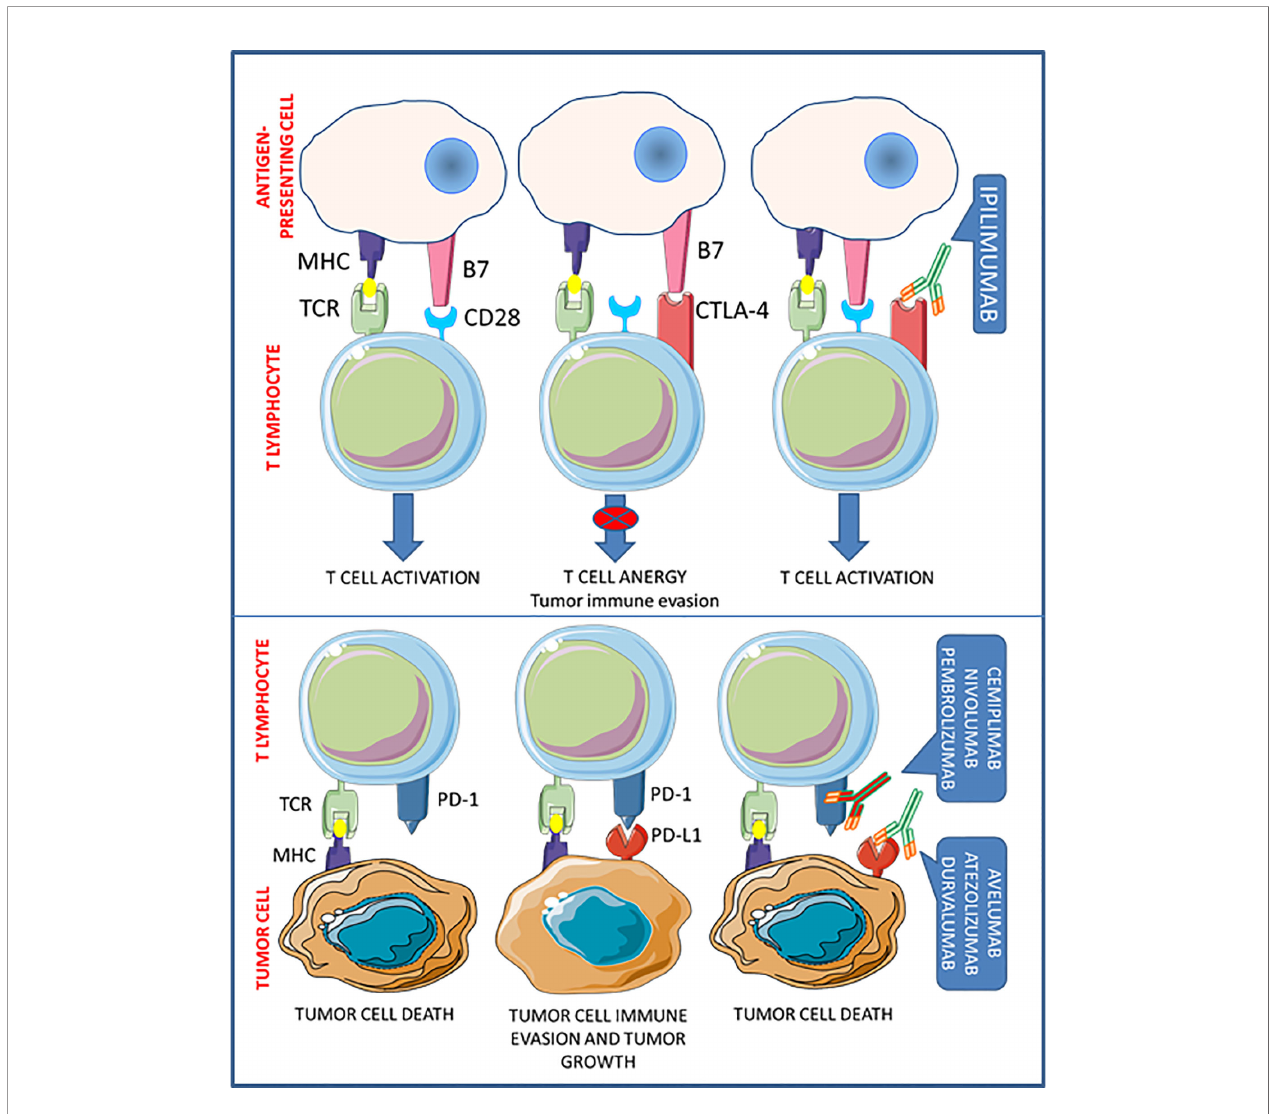
FIGURE 1 | Mechanisms of action for FDA-approved immune checkpoint